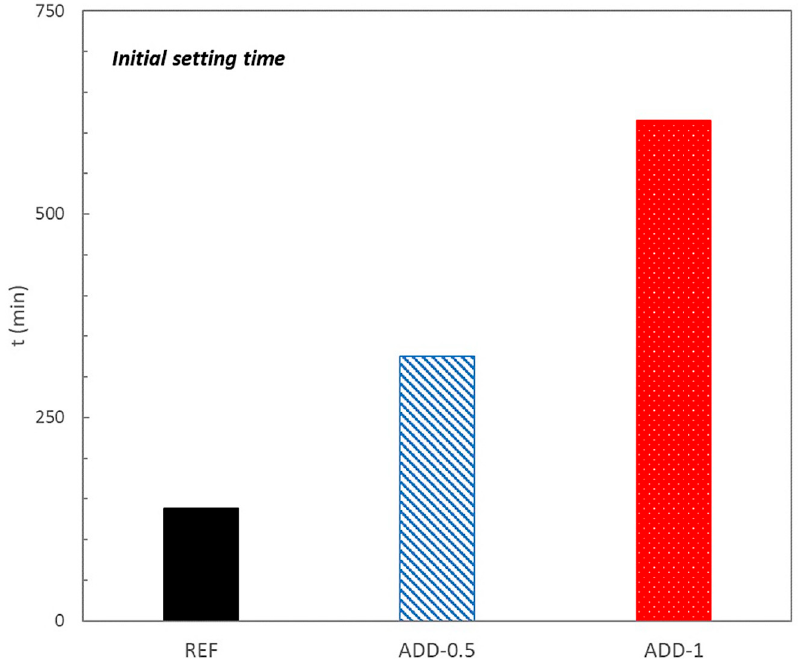
Figure 4. Initial setting time estimated by VICAT needle